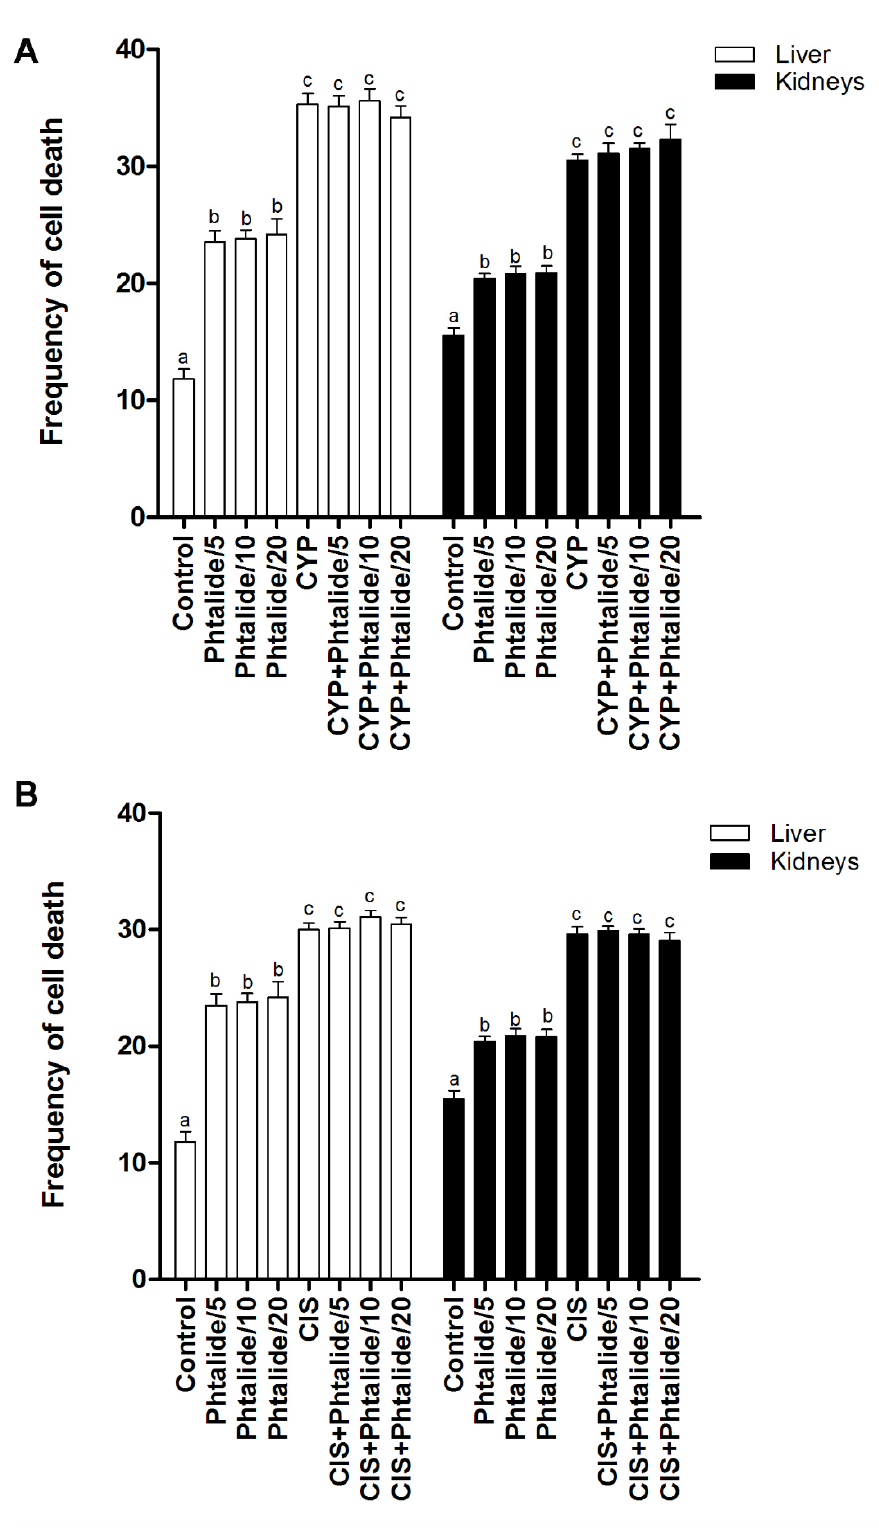
Figure 5. Frequency of cell death. ( A ) Evaluation of cell death in the groups treated with 1 and 1 associated with cyclophosphamide; ( B ) evaluation of cell death in groups treated with 1 and 1 associated with cisplatin. Legend: g: Gram; CYP: Cyclophosphamide; CIS: Cisplatin; 1 : 3-heptylidene-4,6-dimethoxy-3 H -sobenzofuran-1-one; 1 /5 – 5 mg/kg; 1 /10 – 10 mg/kg; 1 /20 – 20 mg/kg. Results are presented as mean ± SEM. Different letters indicate statistically significant differences (Statistical test: ANOVA/Tukey, p < 0.05).